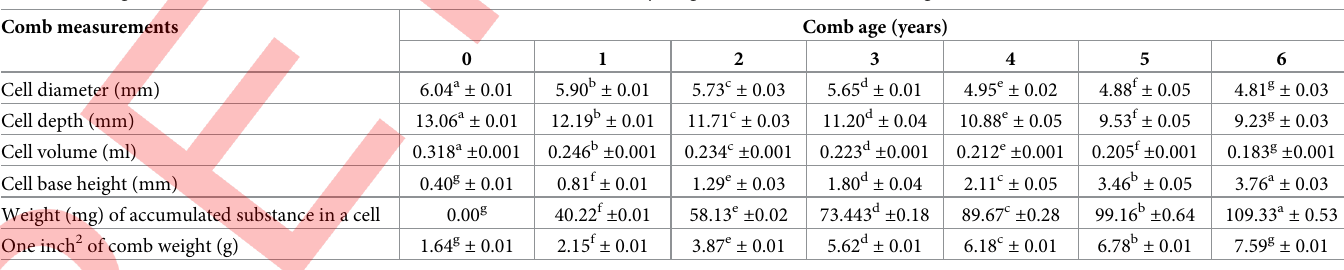
Table 2. Changes in the standard measurements of comb cells and worker body weight in relation to the comb age. Comb measurements